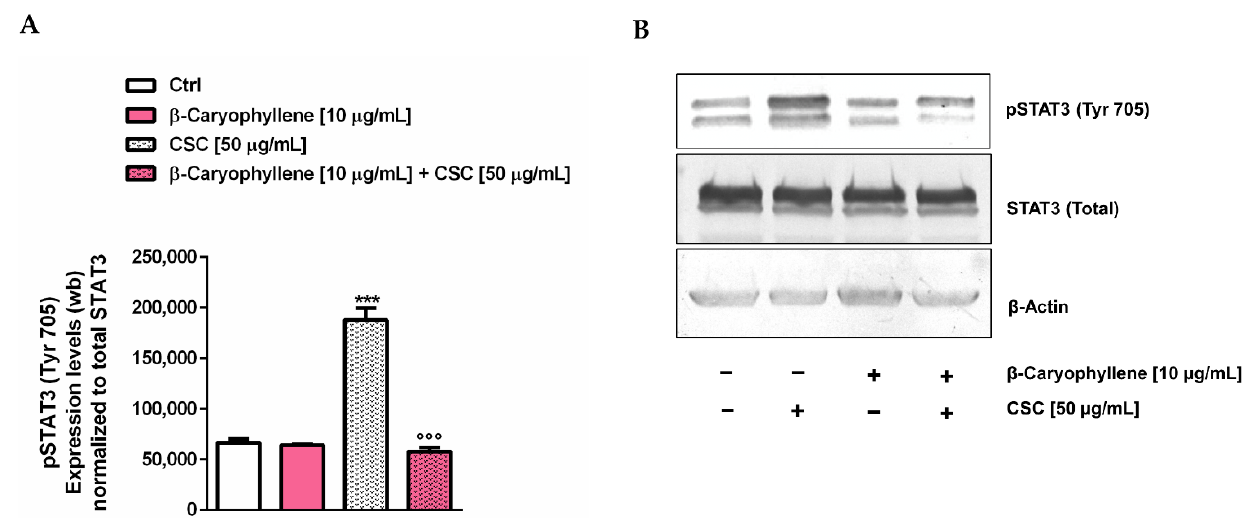
Figure 17. Effect of β -caryophyllene and cigarette smoke condensate (CSC) on the expression levels of phosphorylated STAT3 at tyrosine 705 residue in MDA-MB-468 cancer cells after 24 h exposure. ( A ) Densitometric bar graph analysis (data are expressed as mean ± standard error obtained from at least two independent experiments) ( B ) Representative Western blotting membrane, displaying phospho(Tyr705) STAT3, total STAT3 and β -actin, used as protein-loading controls. *** p < 0.001, significant lowering of cell viability with respect to the control (ANOVA + Dunnett’s multiple comparison post-hoc test). °°° p < 0.001, significant difference with respect to CSC ( Student’s t- test).